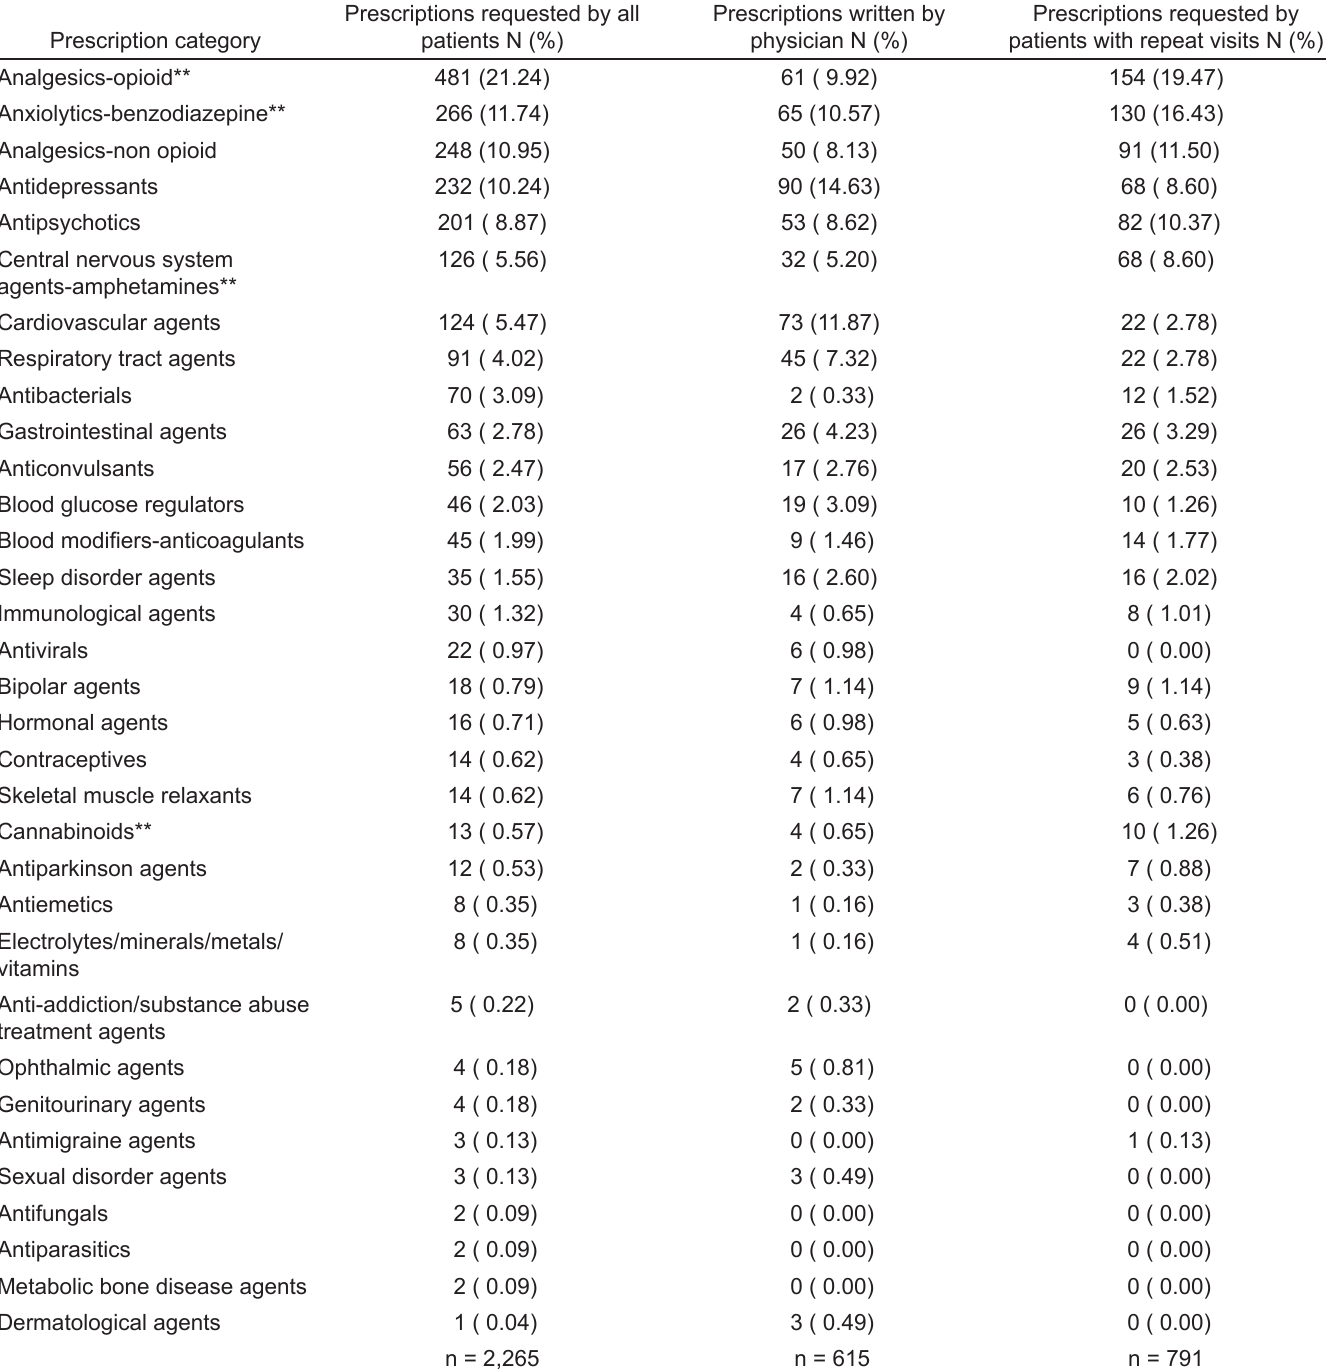
Table 2. Prescriptions requested and written by category for all patients and patients with repeat